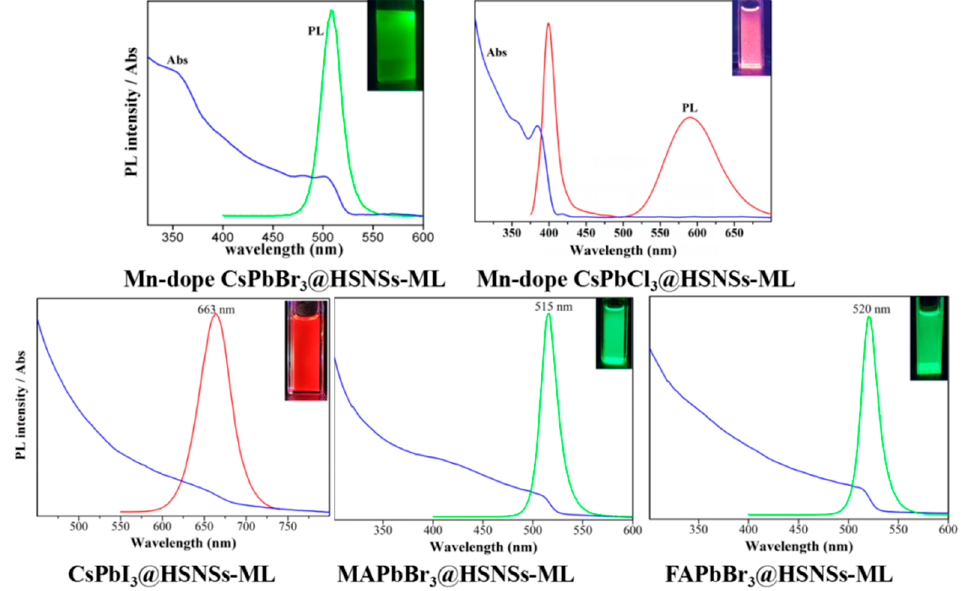
Figure 8. Absorption and PL emission spectra of diverse template-assisted PNCs using purpose HSNSs-ML; illustrations are their photographs under a 365 nm UV lamp.